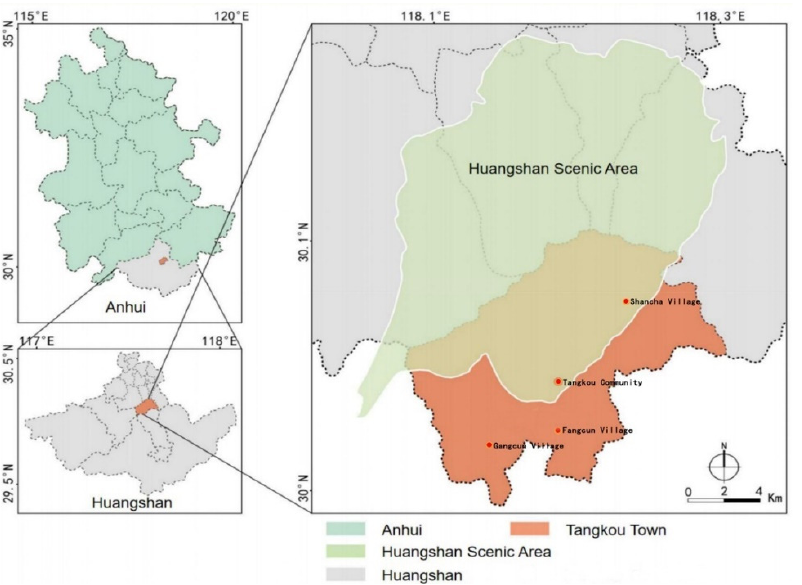
Figure 2. Location of Tangkou Community, Gangcun Village, Fangcun Village and Shancha Village. Source: Modified from Wu et al. [58].